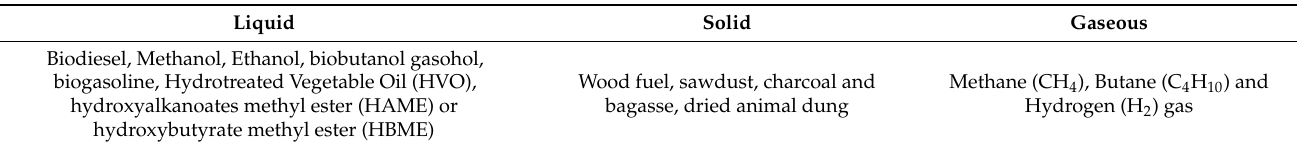
Table 5. Types of biofuels for